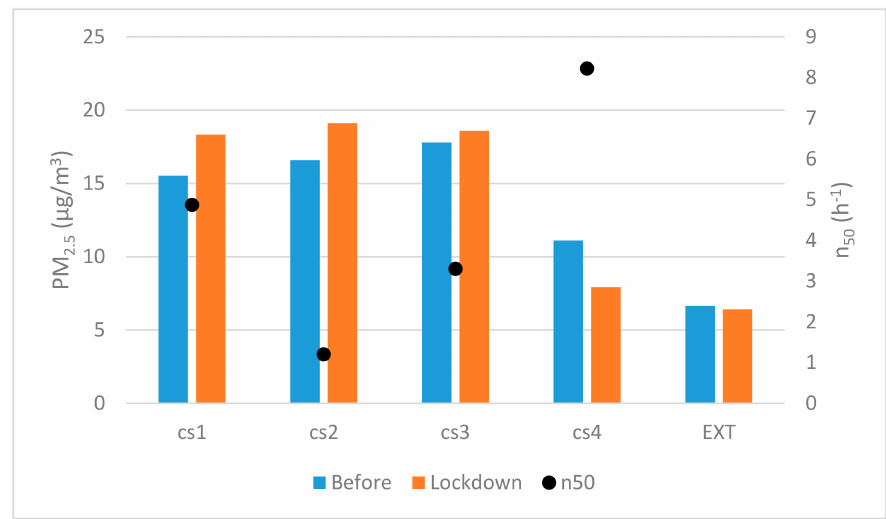
Figure 11. The average PM 2.5 concentration and airflow leakage at 50 Pa (n 50 ) for the case studies for the period before and during the lockdown in Madrid.